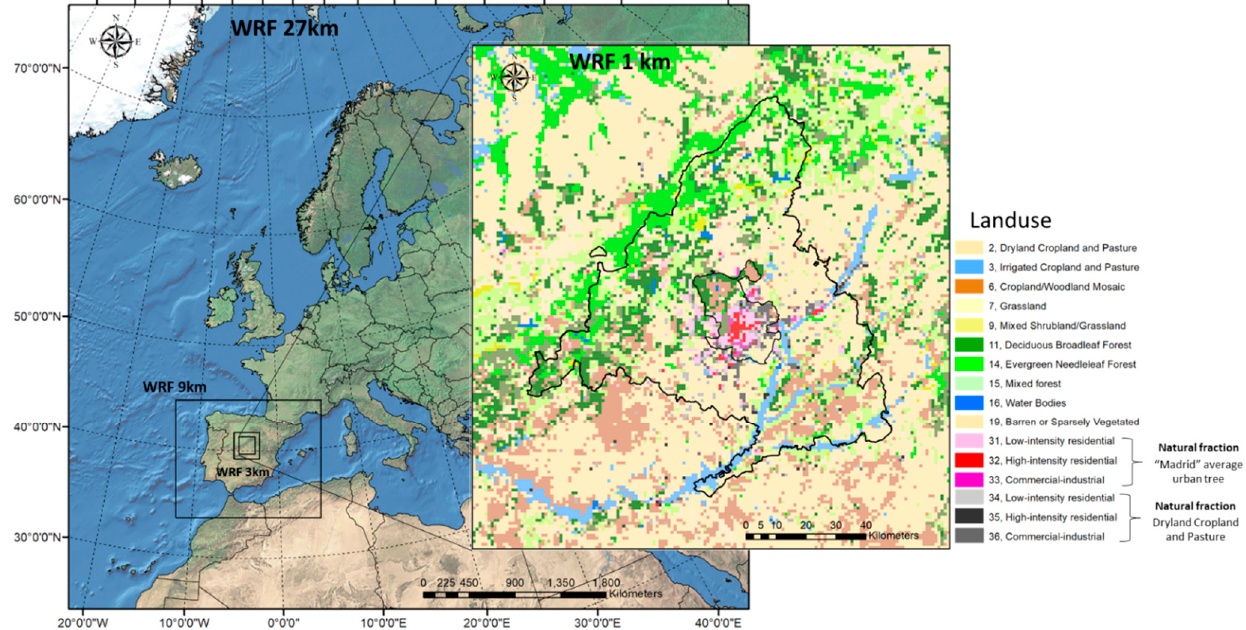
Figure 1. Nested modelling domains and detail of the innermost 1 km 2 resolution domain showing dominant land-use types.